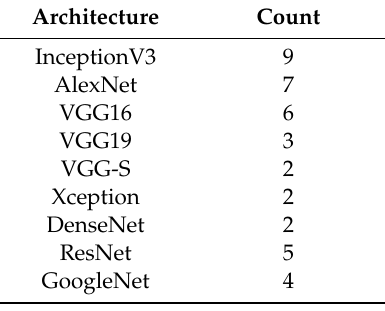
Table 4. Architectures analysis.